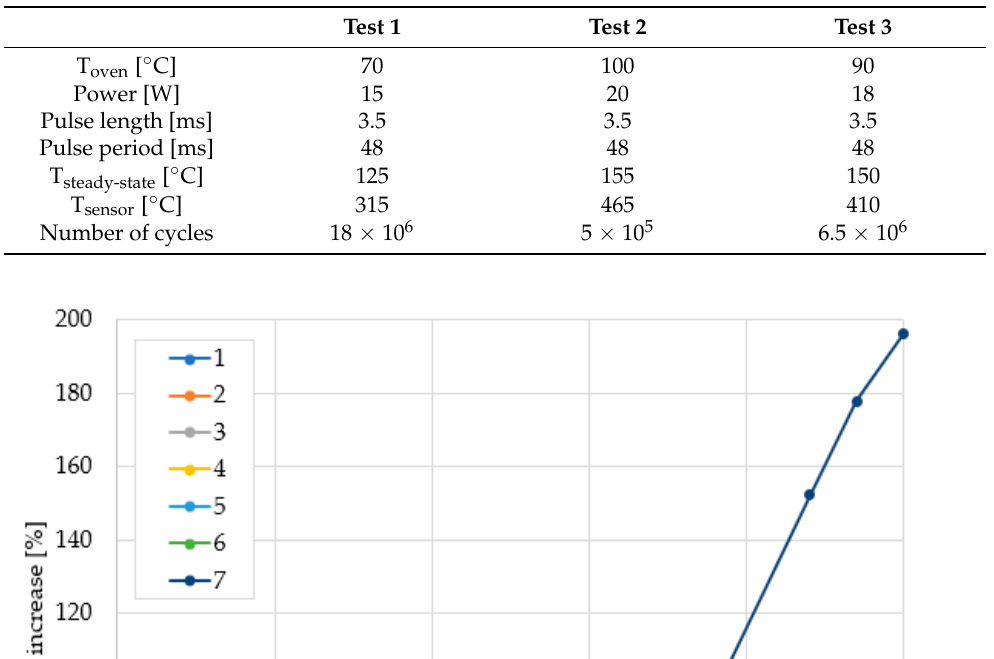
Table 1. Testing conditions for trial.